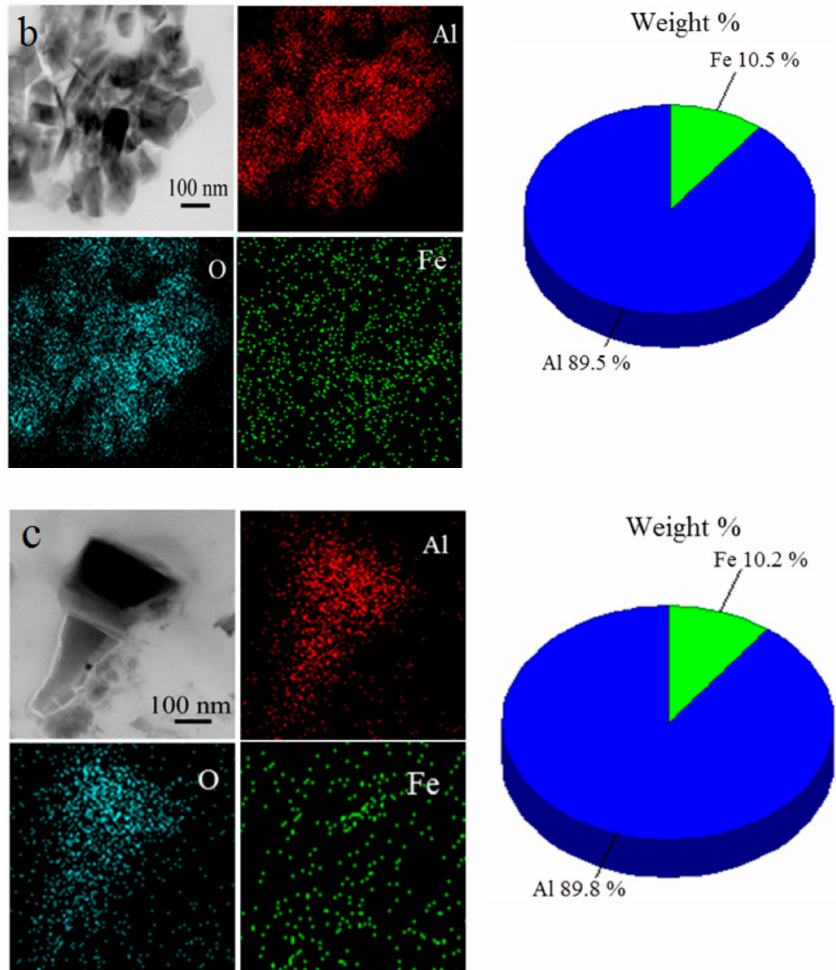
Figure 3. Interaction products of the bimetallic Al/Fe nanoparticles with water and Al/Fe ratio under different conditions: ( a ) in liquid water at 60 ◦ C; ( b ) under hydrothermal conditions at 200 ◦ C; and ( c ) in humid air at 60 ◦